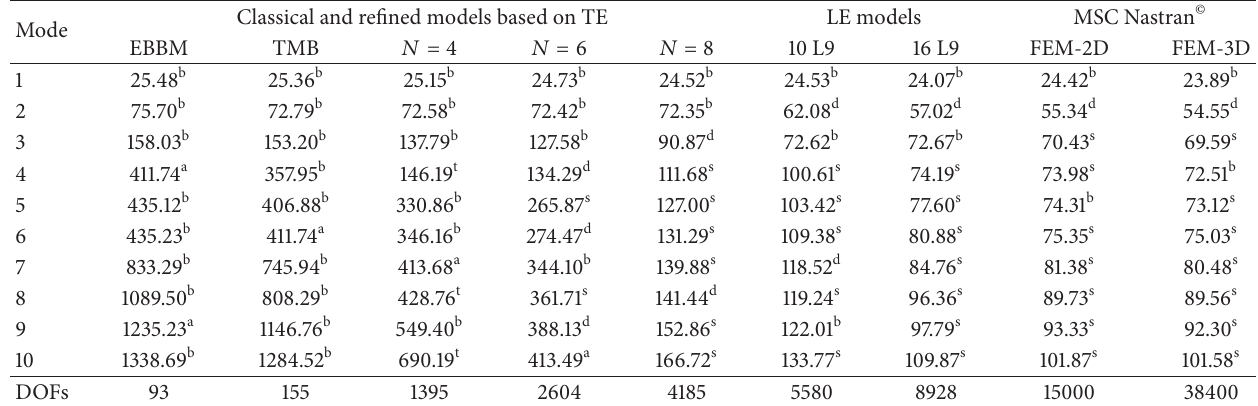
Table 6: First 10 natural frequencies (Hz) for the hollow-rectangular box beam.